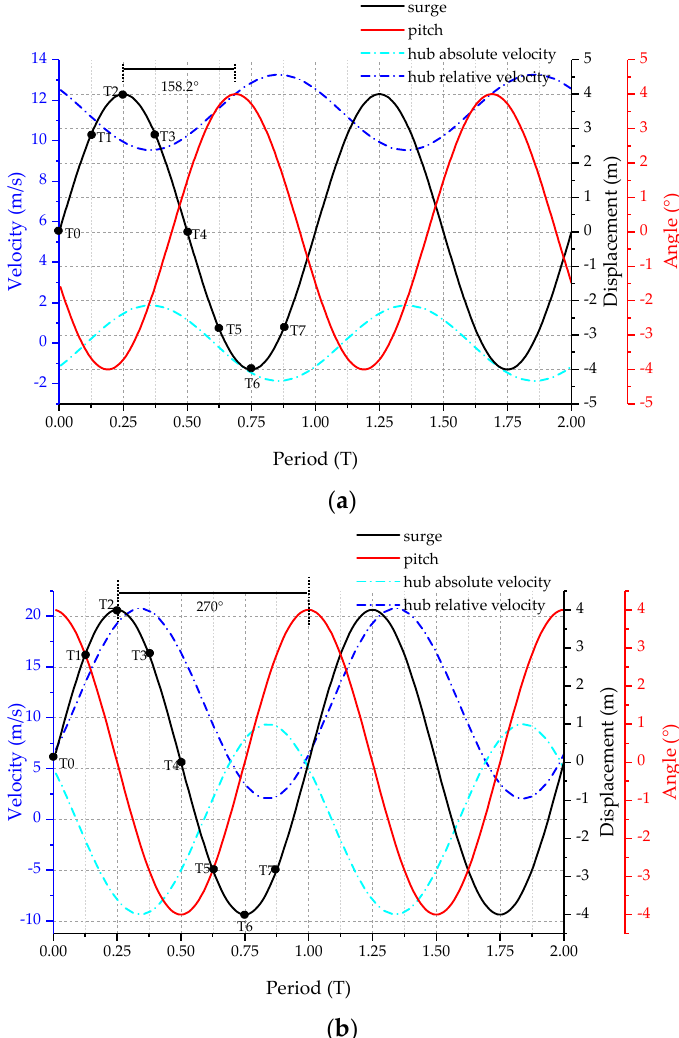
Figure 18. Velocity analysis under combined motion with phase difference. ( a ) Case 20; ( b ) case 22. Under the combined motion with a phase difference, the power variation curves are depicted in Figure 19, and the power statistics are presented in Table 9. First, the power oscillation under the combined motion with a phase difference is smaller than that under the same-phase combined motion. The maximum power of case 17 is reduced by 1.42 MW compared to case 11, and the maximum power of case 21 is reduced by 1.23 MW compared to case 15. It is concluded that the impact on the attenuation of power at 0.1 Hz is greater than that at 0.2 Hz. Furthermore, under different frequencies, the combined motion with phase difference has different power influence characteristics compared to the single motion. At 0.1 Hz, the maximum power of case 17 is smaller than that of the pitch motion of case 1 and the surge motion of case 6; however, at 0.2 Hz, the maximum power of case 20 is larger than that of the pitch motion of case 4 and the surge motion of case 9. This illustrates the mutual weakening effects on power characteristics between pitch and surge motion at 0.1 HZ and the mutual strengthening effects at 0.2 HZ. In addition, under combinations of different motion amplitudes, the characteristic position of the power variation curve is different. At 0.1 Hz, the maximum power occurs near the T7 moment in case 17, near the T5 moment in case 18, and near the T7~T0 moment in case 19. This is mainly because the power is affected by pitch and surge motion amplitude differently.